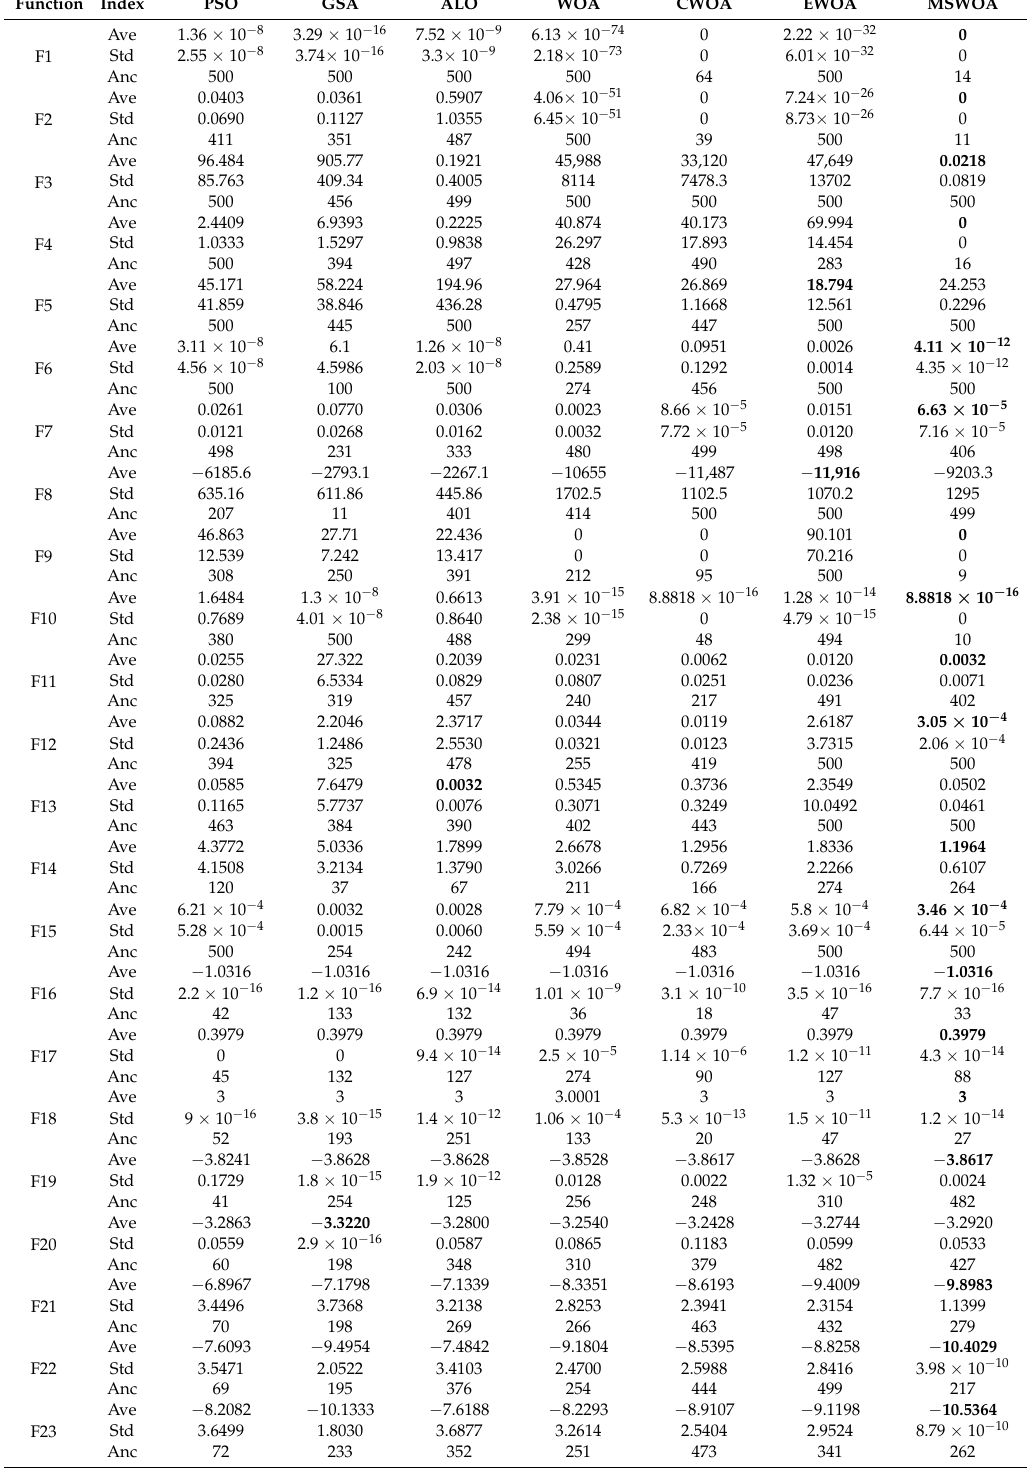
Table 6. Test results of 23 benchmark